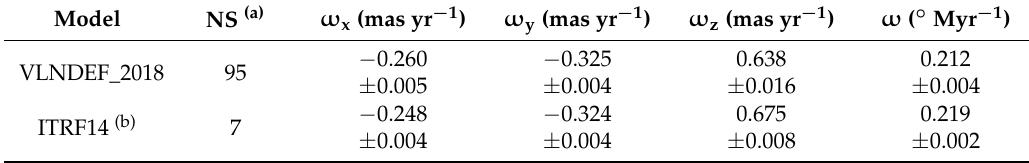
Table 4. Euler poles rotational coordinates (“mas yr − 1 ” = milliarcsecond/yr; “° Myr − 1 ” = degree/Millions yr).